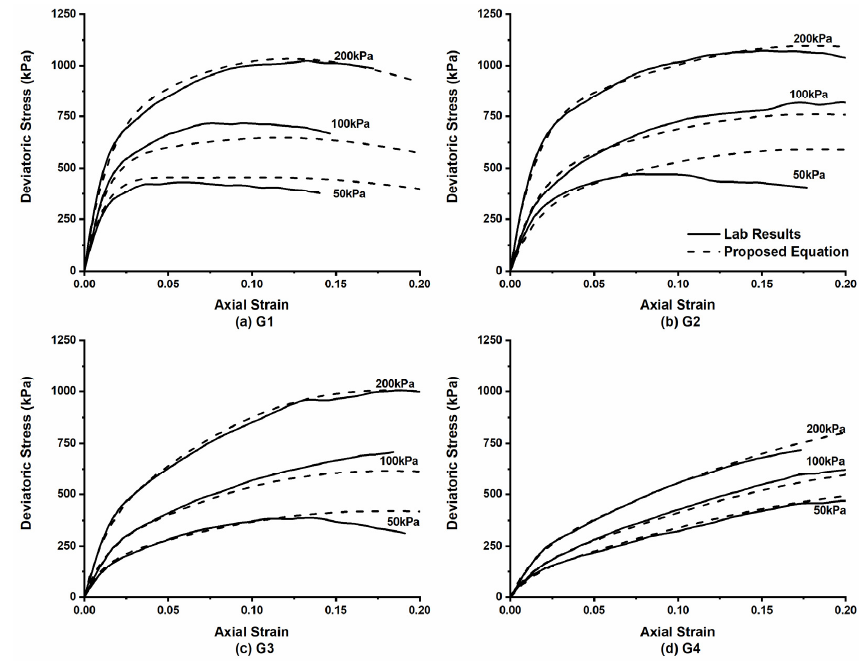
Figure 9. Comparison between laboratory and empirical equation results for gravel mixtures.